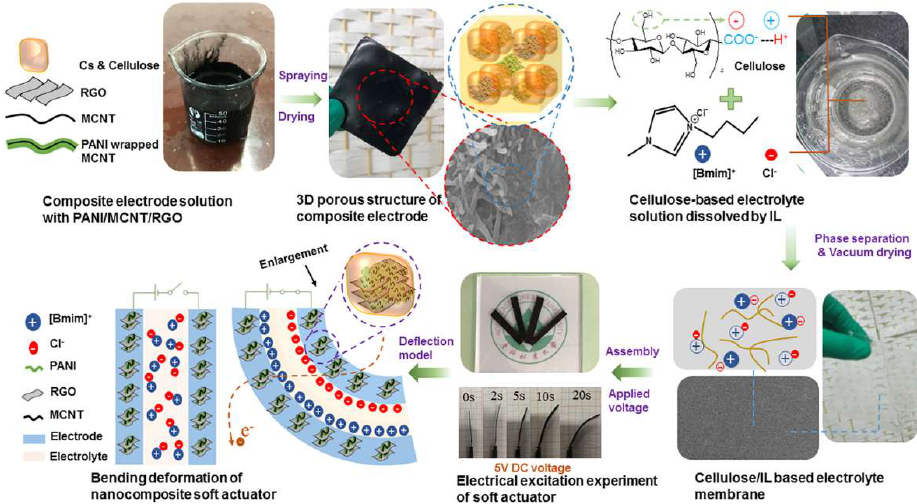
Figure 12. Preparation of renewable biocompatible nanocomposite soft actuator based on three-dimensional porous electrode [86].